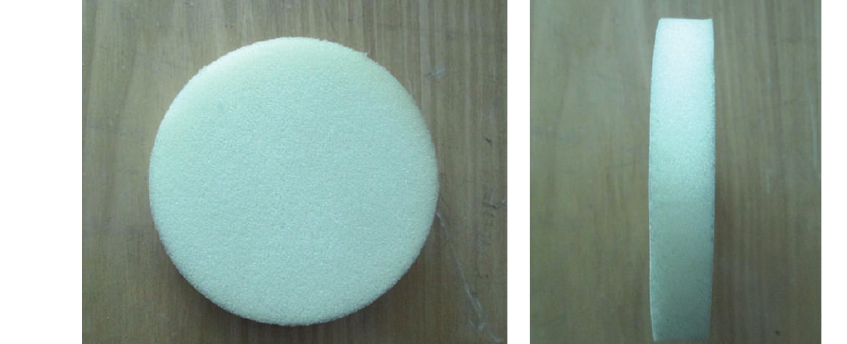
Figure 2: Prepared foams for testing.